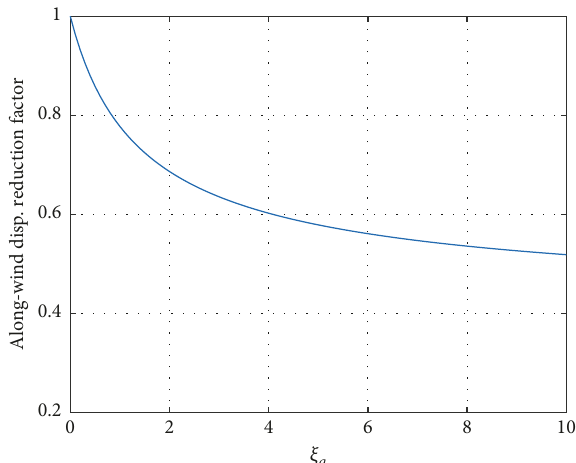
Figure 16: Reduction ratio of the fluctuation component in the gust